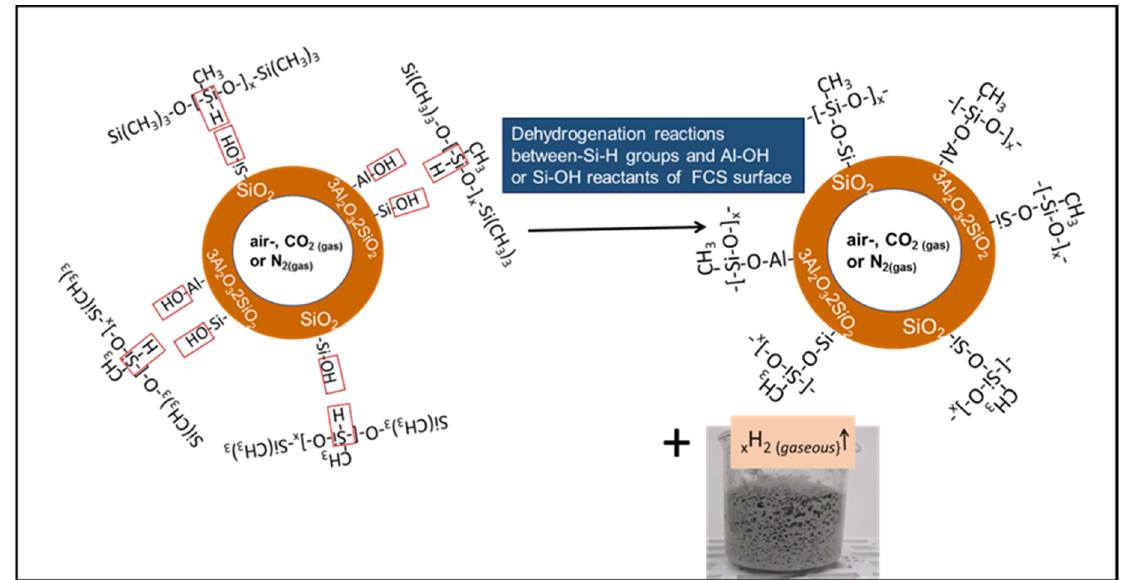
Figure 6. Dehydrogenation reaction between hydroxylated FCS surfaces and Si-H in PMHS at ambient temperature.